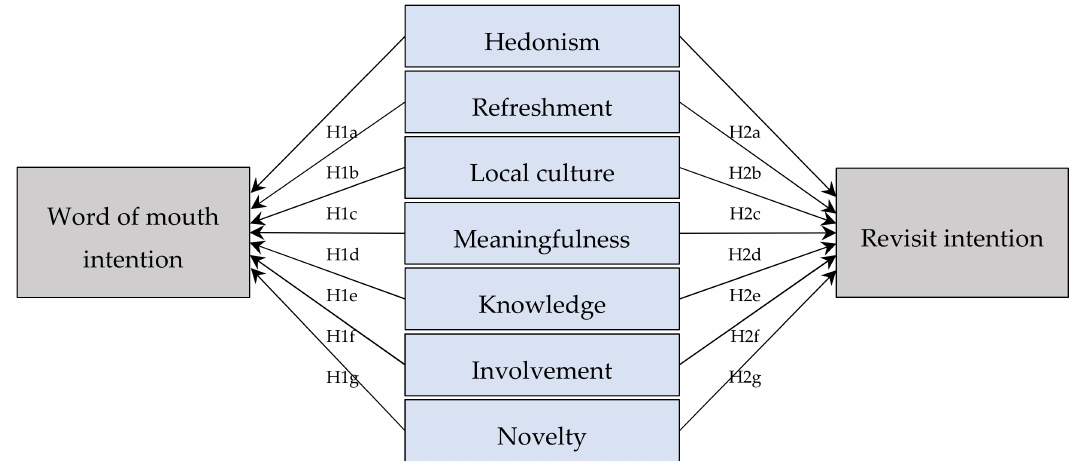
Figure 1. Model and hypotheses of memorable tourism experiences (MTEs) and behavioral intentions of